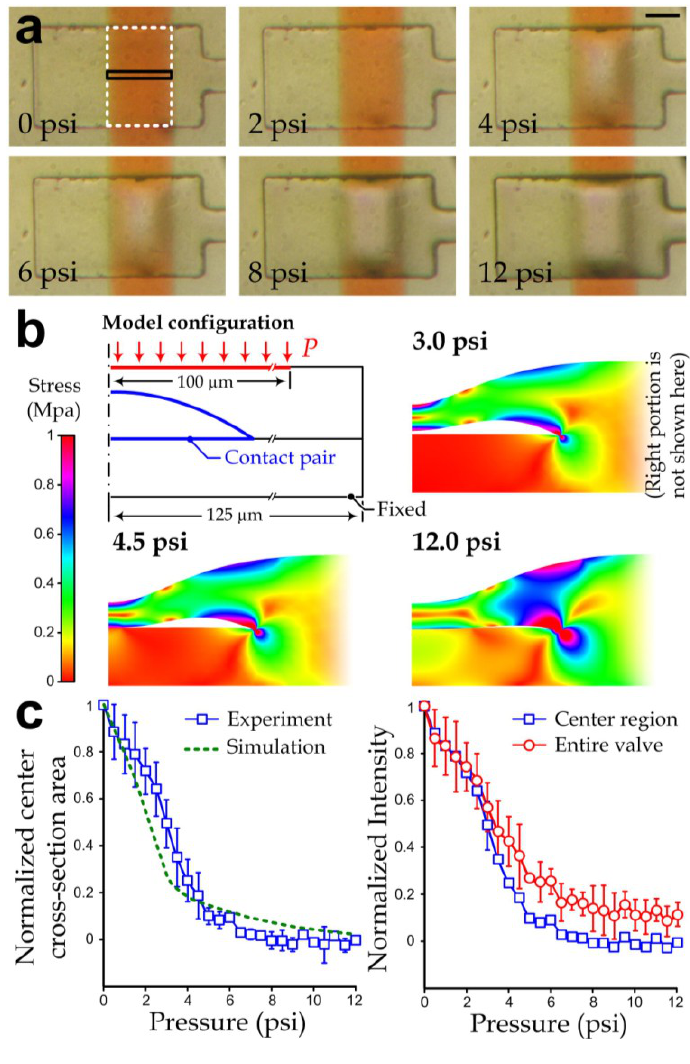
Figure 2. ( a ) Photographs of a representative microvalve under different driving pressures. Scale bar: 50 µm; ( b ) Simulations of deformation at the “center” cross-section in a microvalve ( H = 25 µm) under different levels of a driving pressure ( p ). Sample stress M profiles of the model where p = 3 psi, 4.5 psi and 12 psi are provided here; ( c ) Comparison of the flow channel area at the center cross-section between experimental and simulation values ( left ), and color intensities of microvalve regions in the photographs mentioned in sub-figure a ( right ). Each data point was obtained from measurements of at least 3 devices. Error bars represent the standard